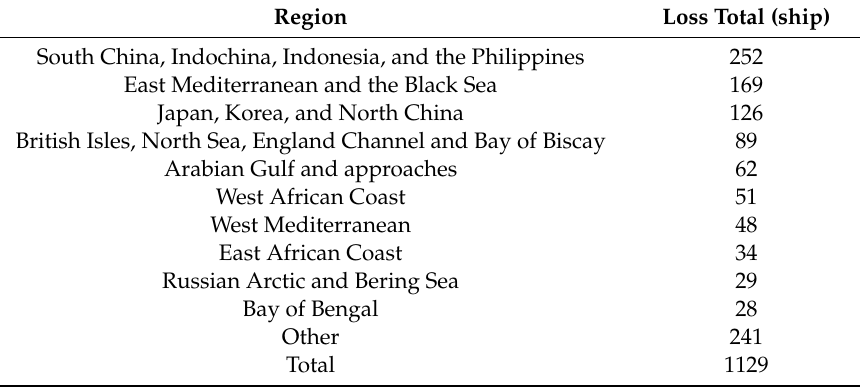
Table 1. Review of total losses by top 10 regions: 2008–2017